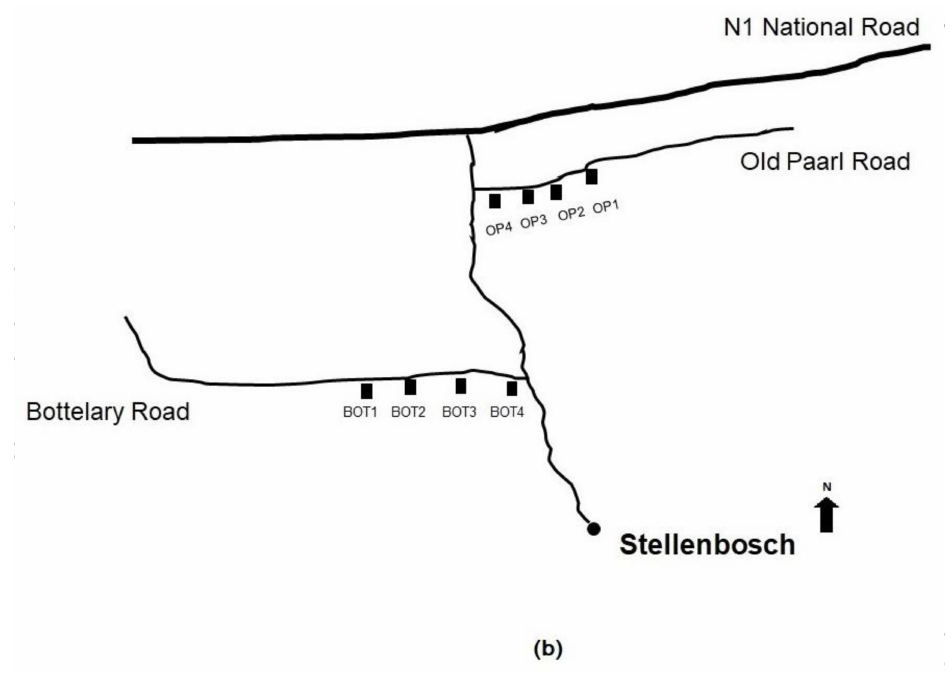
Figure 1. Map of the Cape Peninsula in the Western Cape, South Africa showing the location of the town Stellenbosch (in ( a )) and the two main roads (in ( b )) near the town where dust and soil samples were collected on the Old Paarl Road (OP) and Bottelary Road (BOT), respectively.